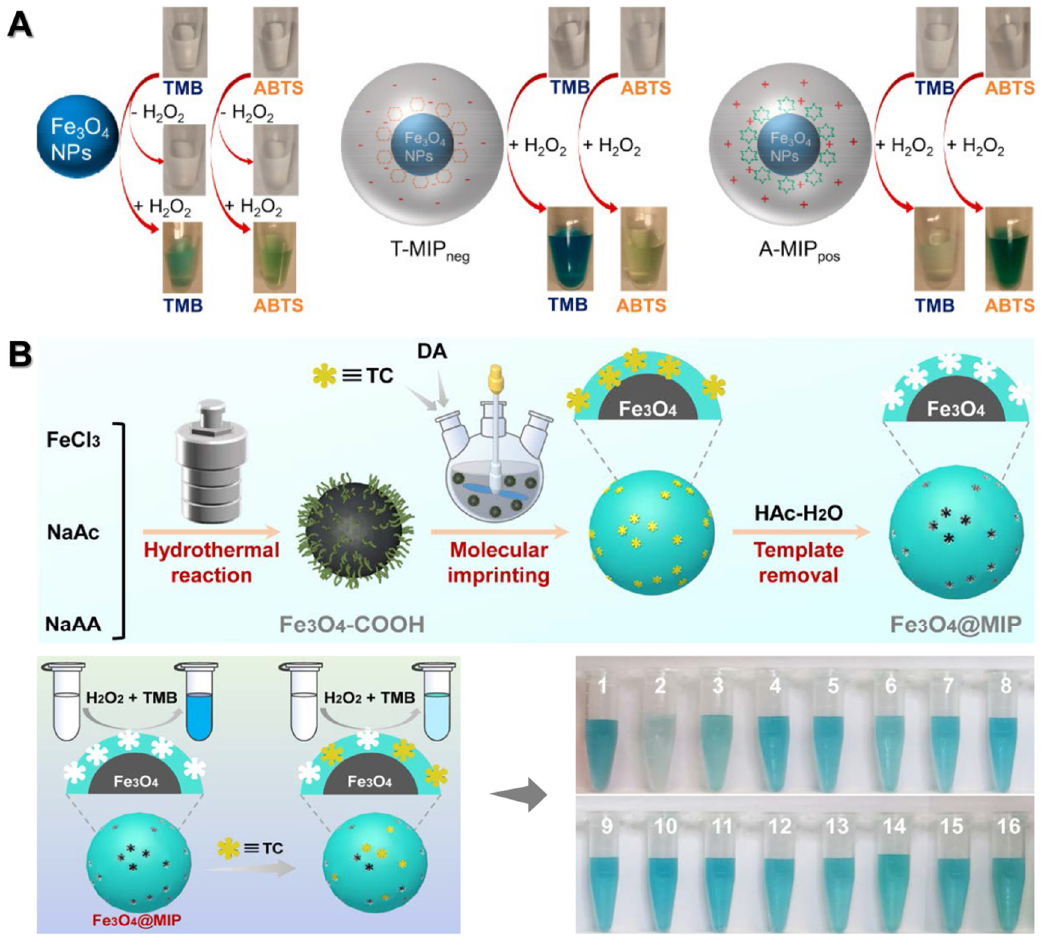
Figure 5. ( A ) Molecularly imprinted layers grown on Fe 3 O 4 NPs with substrate binding pockets for enhanced nanozyme specificity (reprinted with permission from Ref. [83]). ( B ) Molecular imprinting on Fe 3 O 4 particle surface to gain TC colorimetric detection with excellent selectivity (reprinted with permission from Ref. [88]).